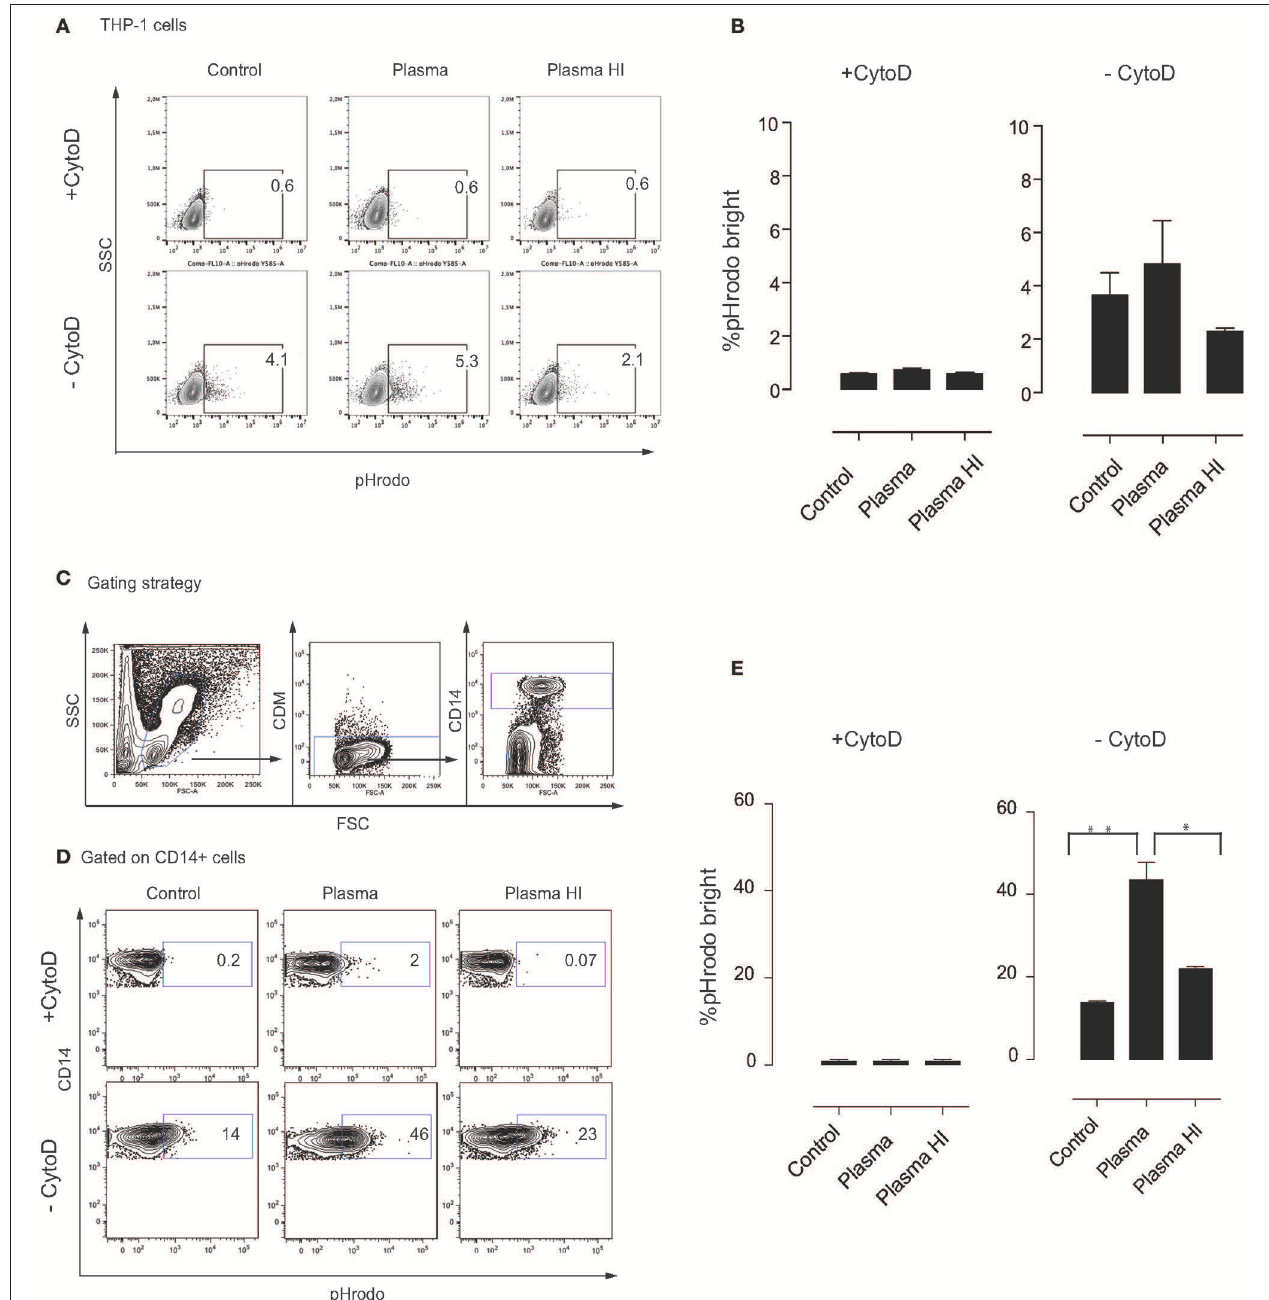
FIGURE 3 | Complement enhances phagocytosis of MSC by monocytes. MSC were labeled with pHrodo and incubated with or without active plasma for 1h, washed and co-cultured with THP-1 cells (A,B) or PBMC (D,E) . Phagocytosis was analyzed after 2h co-culture. Phagocytosis inhibitor Cytochalasin D (CytoD) was added as a negative control. (A) Representative plots of flow-cytometric analysis of phagocytosis by THP-1 cells. pHrodo bright fluorescence indicates cells that have phagocytosed labeled MSC. (B) Pooled data of THP-1 cell phagocytosis, bars represent means with SD ( n = 4) from two independent experiments. (C) Gating strategy of CD14 + monocytes in freshly isolated PBMC. (D) Representative plots of flow-cytometry analysis of phagocytosis by monocytes. pHrodo bright fluorescence indicates cells that have phagocytosed labeled MSC. (E) Pooled data from MSC phagocytosis by monocytes, bars represent means with SD ( n = 4) of two independent experiments. Statistical significance was determined using ANOVA followed by Holm-Sidak’s multiple comparisons test * p = 0.05, ** p = 0.001.